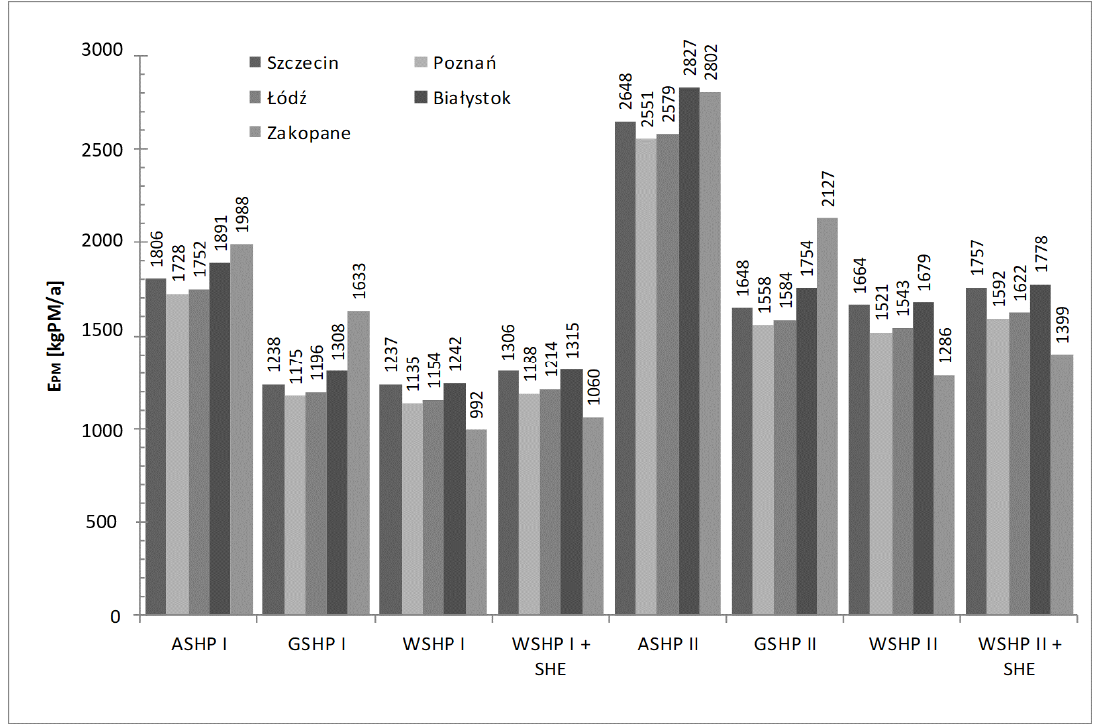
Figure 9. Indirect emissions of PM values for specific locations in the variants I and II.